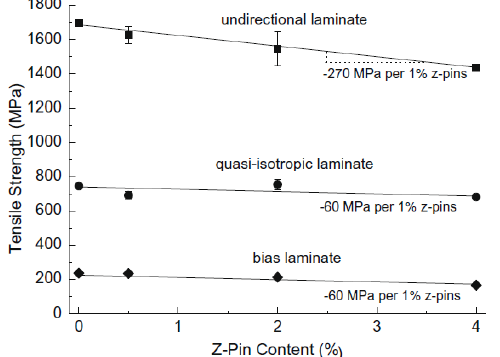
F igure 40. Effect of z-Pin content on Figure 40. E ff ect of z-Pin content on tensile strength due to z-Pinning on various lay-up laminates tensile strength due to z-Pinning on (CFRP z-Pins, d = 0.28 mm, pre-preg)